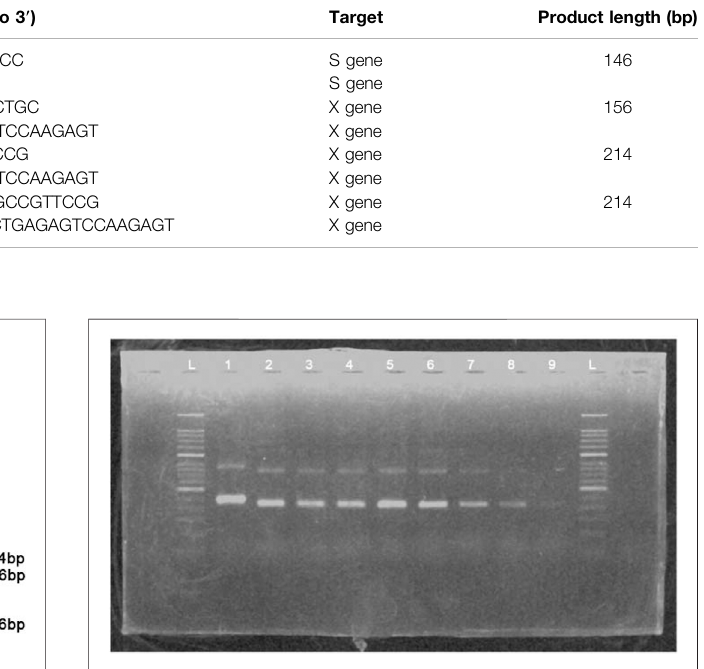
FIGURE 3 | The products of a serial dilution of HBV plasmid deoxyribonucleic acid (DNA) measured in 2% agarose gel electrophoresis. L, 50 bp DNA ladder; 1, positive control ( ∼ 250 bp); 2, product of 25-ng template; 3, product of 5-ng template; 4, product of 1-ng template; 5, product of200-pg template;6, product of 100-pg template; 7, product of50- pg template; 8, product of 25-pg template; 9, product of 12.5-pg